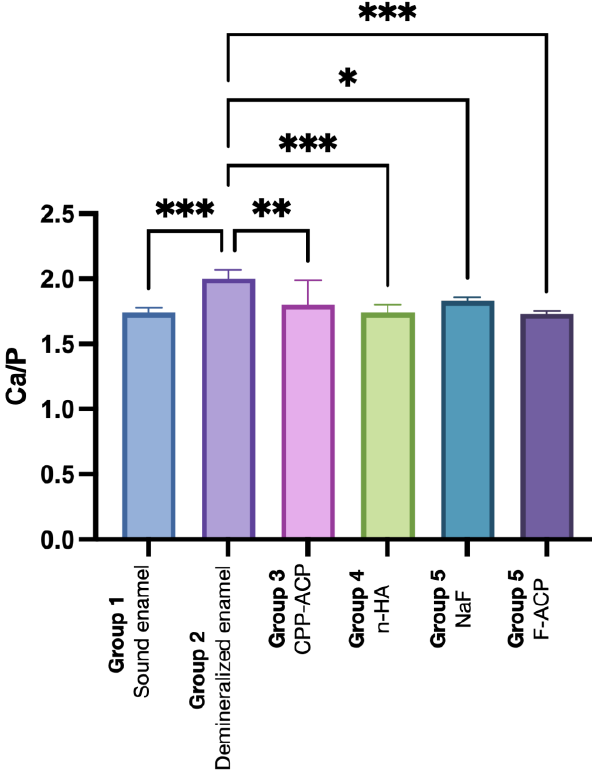
Figure 7. Ca/P ratio results determined using the EDX of all groups in atomic % expressed as mean and standard deviation. One- way ANOVA with Tukey’s multiple comparison test; p < 0.05 is sig- nificant. The following levels of statistical significance were considered: p < 0.05 *, p < 0.01 **; p < 0.001 ***. Comparisons between groups that are not statistically significant are not reported in the graph: Group 1 (Sound enamel), Group 2 (Demineralized enamel), Group 3 (CPP-ACP), Group 4 (n-HA), Group 5 (NaF), and Group 6 (F-ACP), respectively.